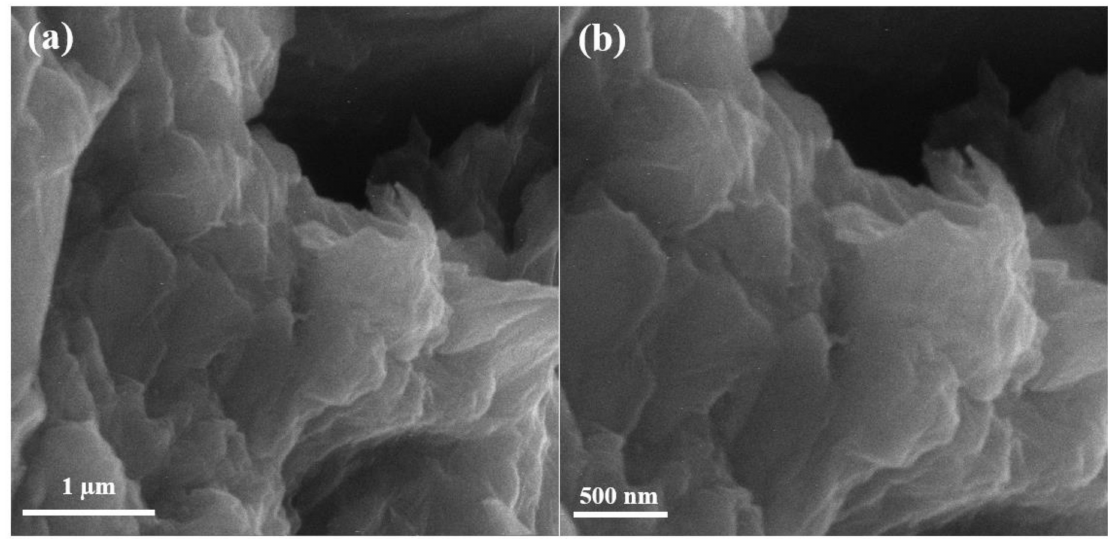
Figure 2. Scanning electron microscopy images of graphene oxide at ( a ) 50,000 × , ( b ) 70,000 × .